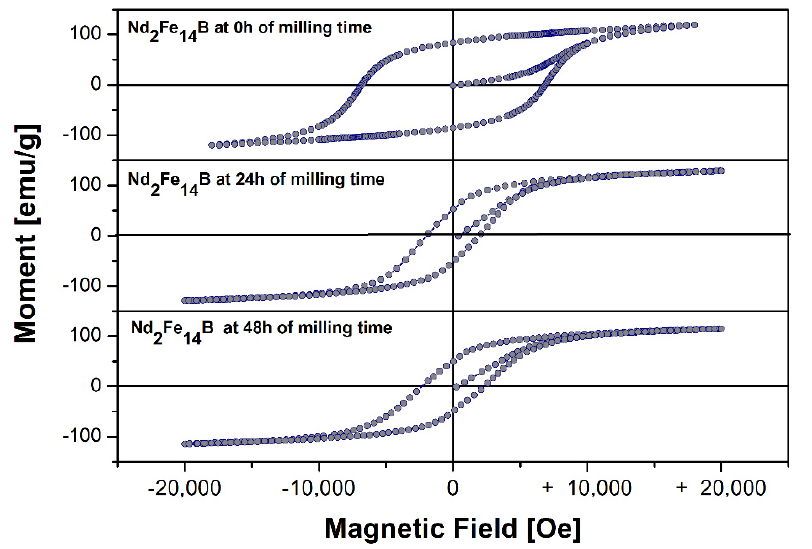
Figure 8. Hysteresis loops of the Nd 2 Fe 14 B system and mechanically alloyed for 24 and 48 h, respectively. Table 6. Extrinsic magnetic properties of the Nd 2 Fe 14 B system and milled for 24 and 48 h with oleic acid as